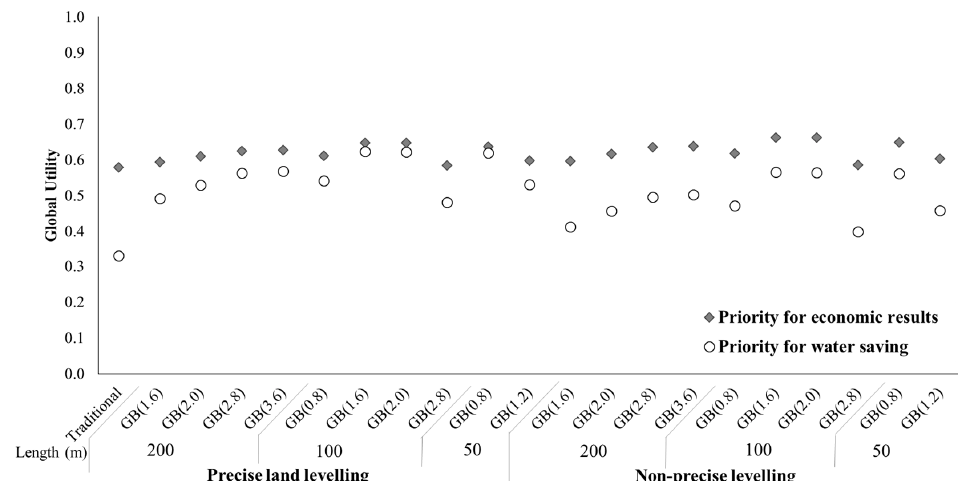
Figure 6. Global utility value for graded borders when the priority is assigned to economic results or to water saving. The value in brackets represents inflow rates (L ∙ s − 1 m − 1 ).